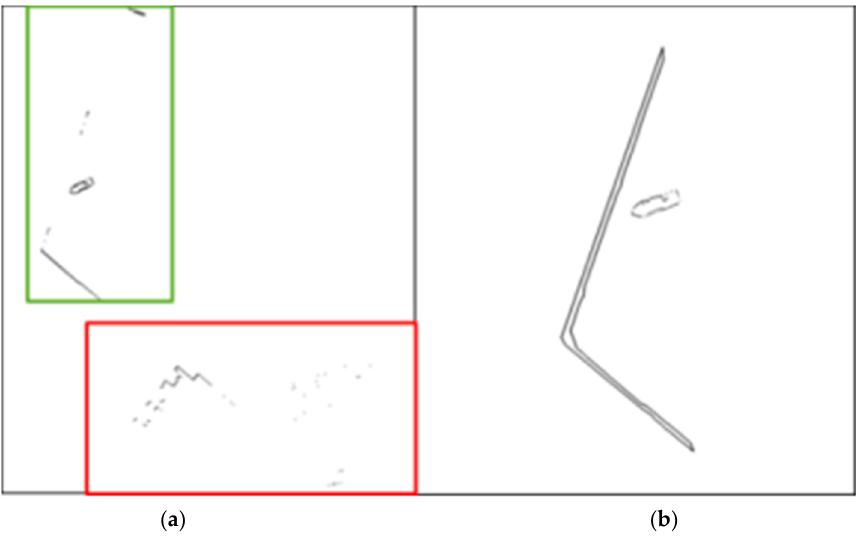
Figure 10. ( a ) Raw LiDAR data transformed into a global coordinate system. In green: identified quay wall, red: static infrastructure removed from further processing. ( b ) resulting data after point cloud preprocessing. Quay wall points were replaced by the quay wall shape resulting from the world model.